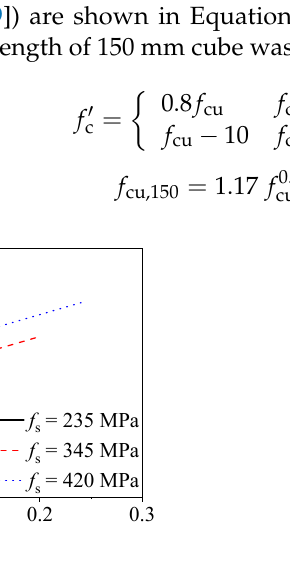
Figure 4. Constitutive relations of steel tube with different yield strength.